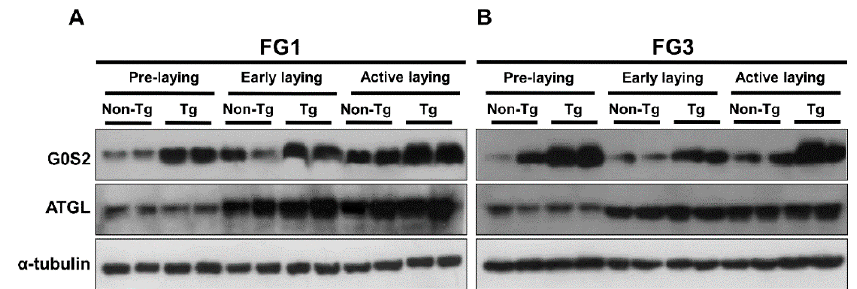
Figure 4. Protein expression of G0S2 and ATGL is altered in transgenic quail. Expression of G0S2 and ATGL in adipose tissue of ( A ) line FG1 and ( B ) line FG3 with α -tubulin as a reference. Two non-transgenic and two transgenic quail from each stage of laying were randomly selected to demonstrate the different expression patterns of G0S2 and ATGL between the groups and across laying stages.